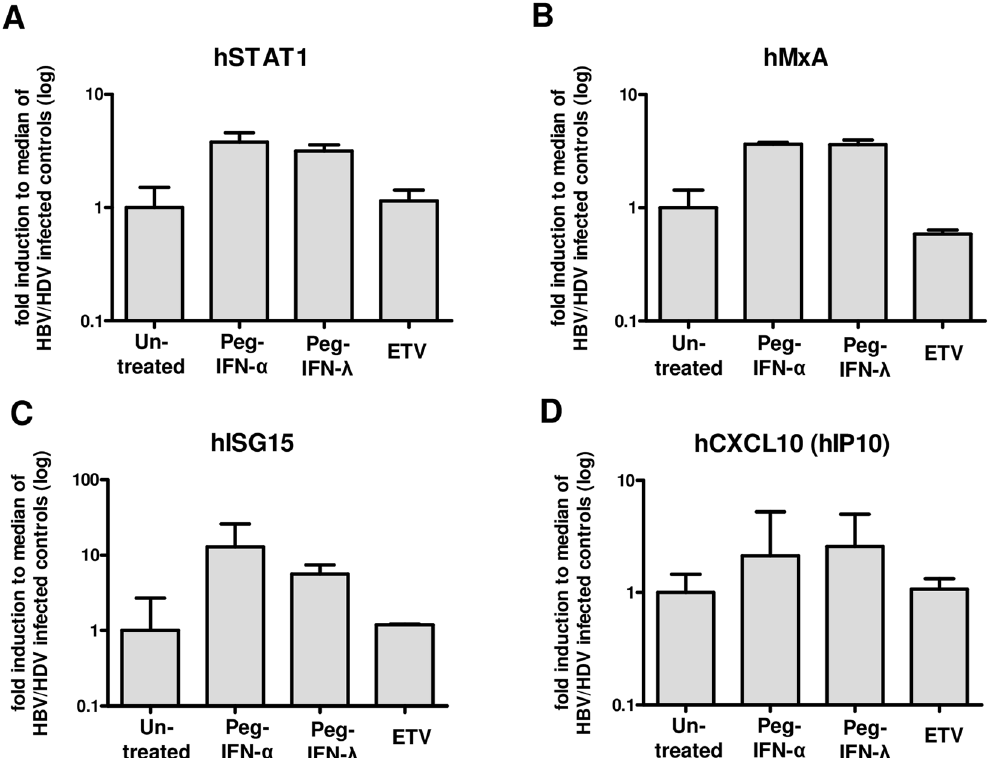
Figure 6. Interferon-stimulated genes. Expression of human specific signalling genes (hSTAT 1, ( A ), interferon-stimulated genes (hMxA, ( B ) hISG15, ( C ) and cytokines (hCXCL10, ( D ) in HBV/HDV infected untreated and peg-IFN α , peg-IFN λ and ETV treated animals. Expression levels are relative the median of two housekeeping genes (hGAPDH, hRPL30). Depicted is the log fold induction (median and range) from median of untreated